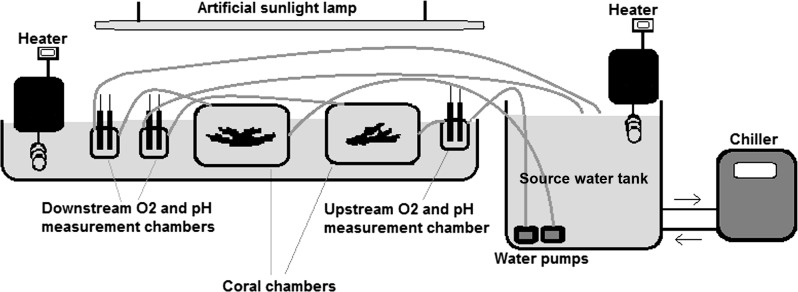
The experimental set up.Seawater collected from the study site was pumped from the source-water tank through the system at a constant rate of about 0.5 l. min−1. Oxygen concentration (mg. l−1) and pH were recorded upstream and downstream the coral chambers every 5 min. 6,500 lux light (i.e. about 120 µ mol. m−2 .s−1) was provided by an artificial sunlight lamp (Dymax Rex-2). Water temperature was controlled by heaters (Lauda E100, with accuracy of ± 0.1 ° C) and a chiller (Aqua medic Titan 1500, with accuracy of ±0.5 °C). Net photosynthesis or respiration rate of corals was calculated in light and dark conditions as the difference in O2 concentration between the upstream and downstream chamber multiplied by the flow rate. The measured metabolic fluxes were not affected by gas exchange with the atmosphere since the measurement and sample chambers were in a closed circuit and water was exposed to air only in the source tank.